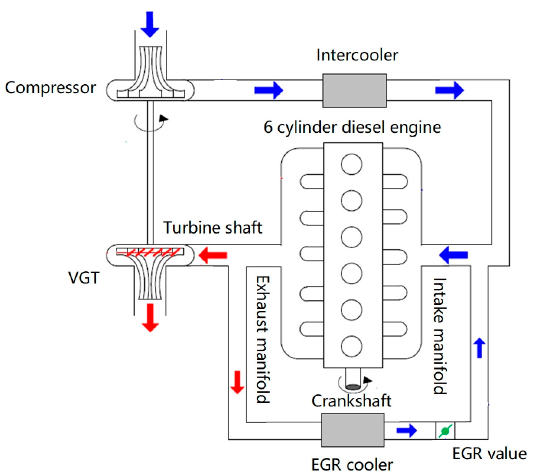
Figure 2. VGT-equipped diesel engine with exhaust gas recirculation (EGR) system.